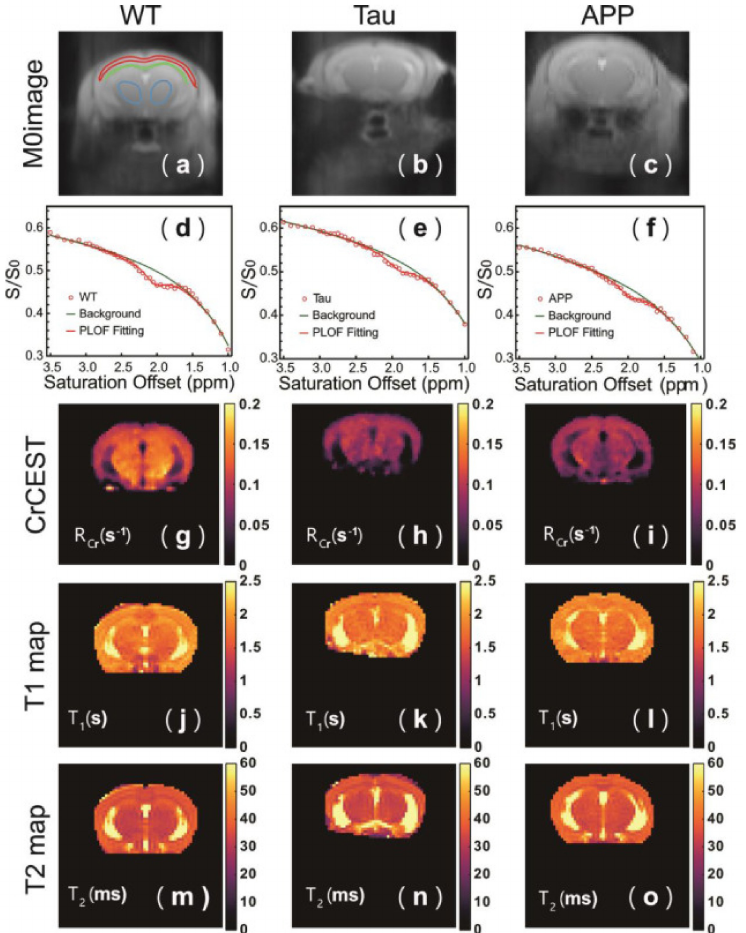
Figure 3. CrCEST imaging of mouse brain. Typical S 0 images ( a – c ), cortical CrCEST Z-spectra ( d – f ), CrCEST maps ( g – i ), T 1 maps ( j – l ), and T 2 maps ( m – o ) for WT ( a , d , g , j , m ), Tau ( b , e , h , k , n ),